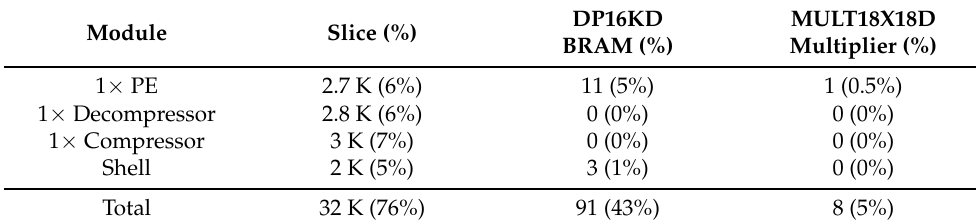
Table 1. On-chip resource utilization breakdown. Module Slice (%)